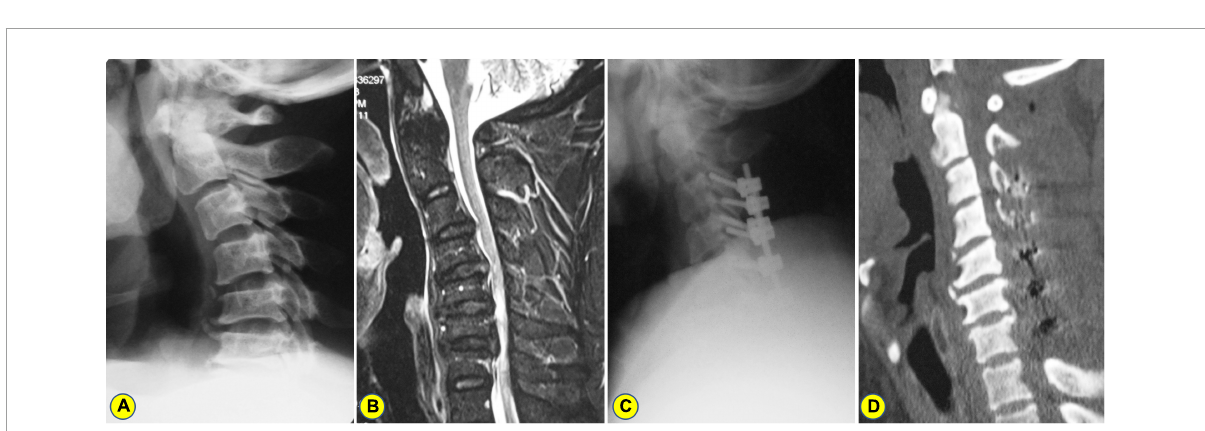
FIGURE4 A 51-years-old man who underwent laminectomy with lateral mass screw fixation. (A) The preoperative lateral X-ray shows the C2-7 Cobb angle and curvature index (CI) are 17 ◦ and 9.45%, respectively. (B) Preoperative magnetic resonance imaging (MRI) showing C3–7 spinal cord compression combined with kyphosis. (C) A postoperative lateral X-ray showing laminectomy with lateral mass screw fixation. (D) On the CT image of 3 years after surgery, the C2-7 Cobb angle and CI were 6 ◦ and 13.09%,